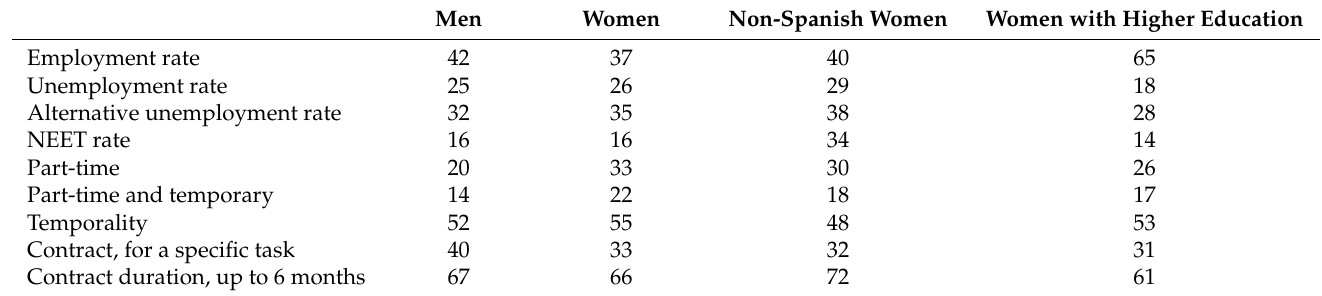
Table 4. Employment, unemployment, and temporality rates, first term of 2020.